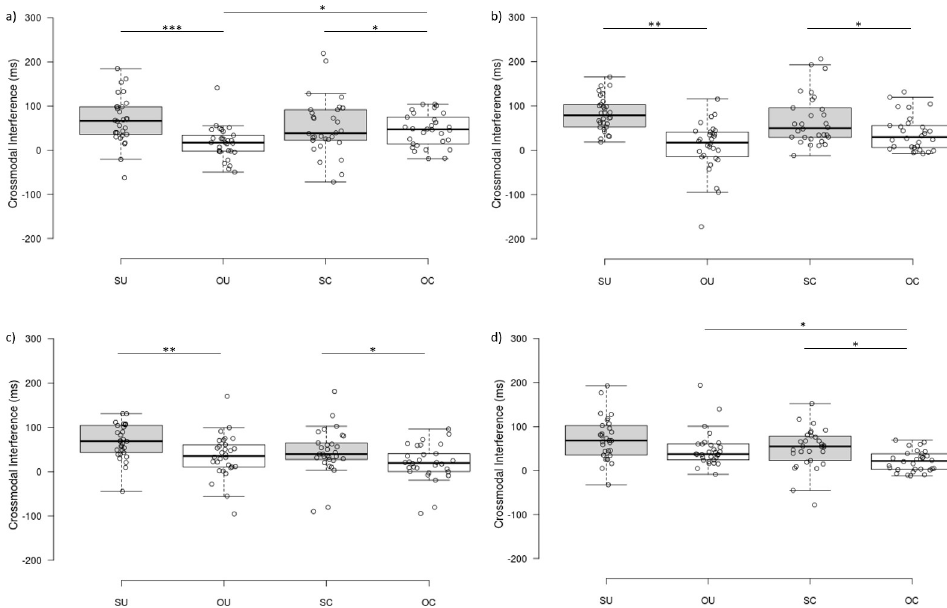
Fig 4. Crossmodal interference–four-way interaction. Crossmodal interference shown by Set (1 [passive], 2, 3, 4) Tool Arrangement (uncrossed, crossed) and Visual Field (same, opposite) for reaction times on the Crossmodal Congruency Task (CCT), for all participants (n = 30). Crossmodal interference was calculated by subtracting congruent from incongruent reaction times. Circles depict individual data points. Medians are depicted by the centre lines. The box limits indicate the 25ht and 75 th percentile. The whiskers extend 1.5 times the interquartile range from the box limits. Circles depict individual data points � p < .05, �� p < .01, ��� p < .001.